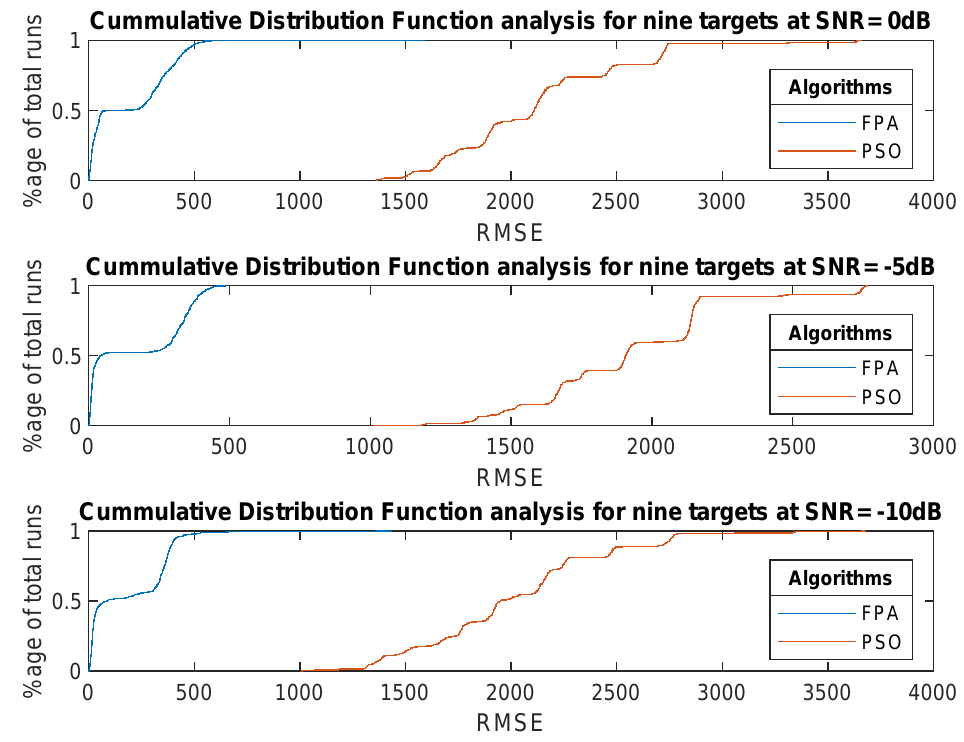
Figure 14. CDF analysis of RMSE for nine targets at different SNRs.